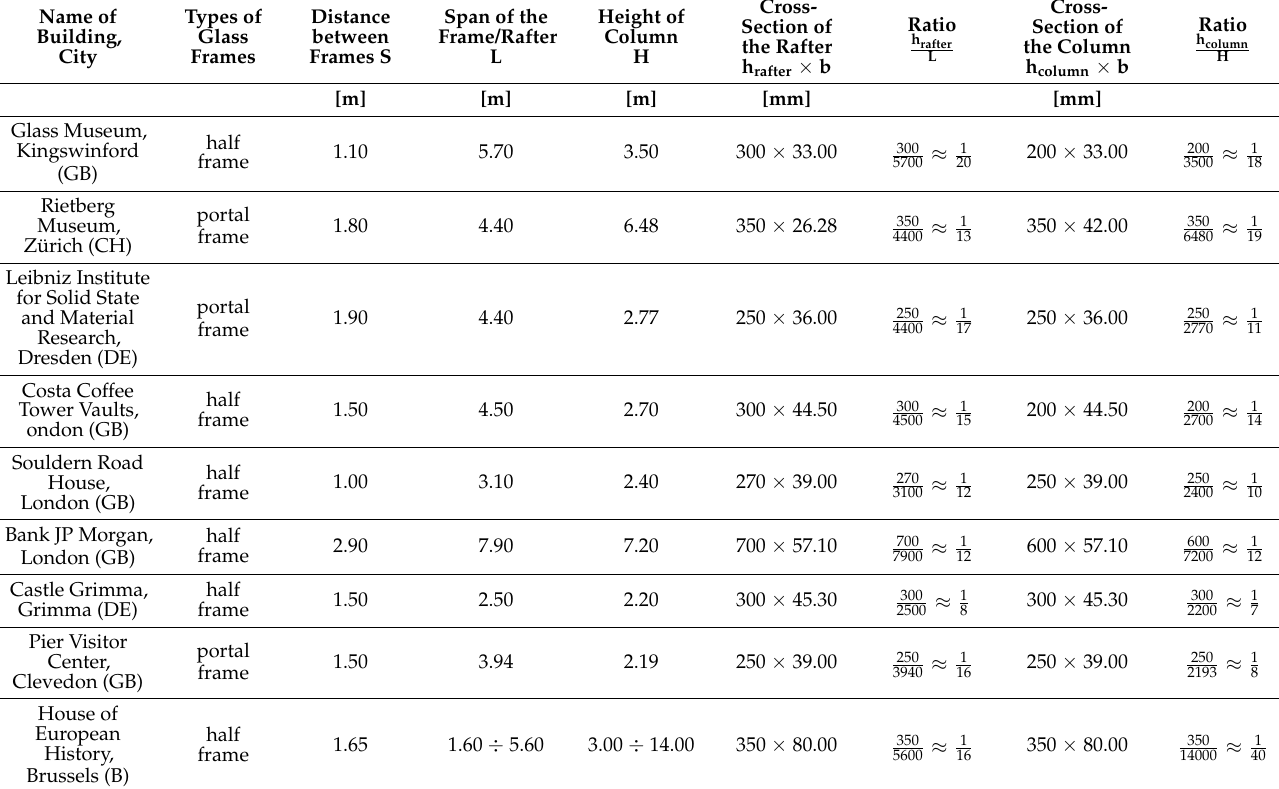
Table 3. Analysis of the geometrical condition of the glass